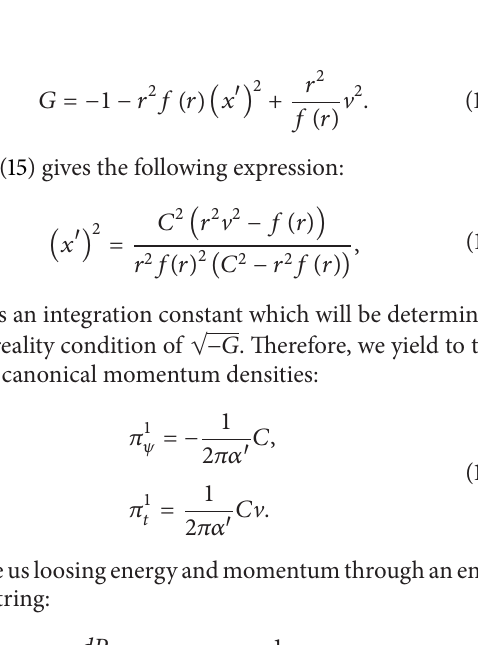
Figure 1: Drag force in terms of 𝐵 for 𝑀 = 1 , 𝑙 = 1 , and V = 0.1 ; 𝑎 = 1.8 (dotted line), 𝑎 = 3 (solid line), and 𝑎 = 4.2 (dashed